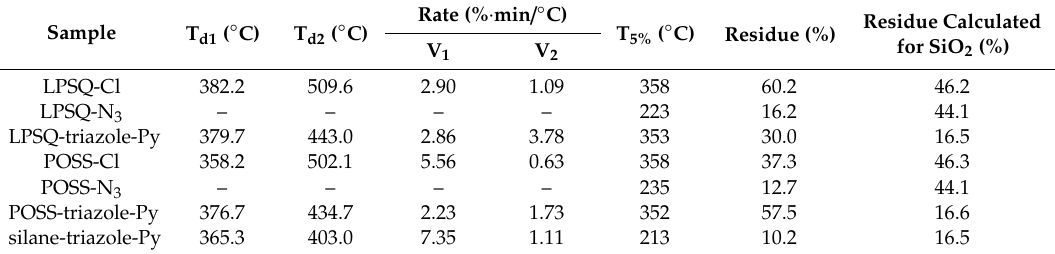
Figure 3. Thermogravimetric analysis of ( a ) LPSQ-triazole-Py and ( b ) LPSQ-amides-Py (N 2 atmosphere, 10 °C/min). Table 1. Thermal degradation characteristics of LPSQ and POSS-triazole-Py and their precursors.